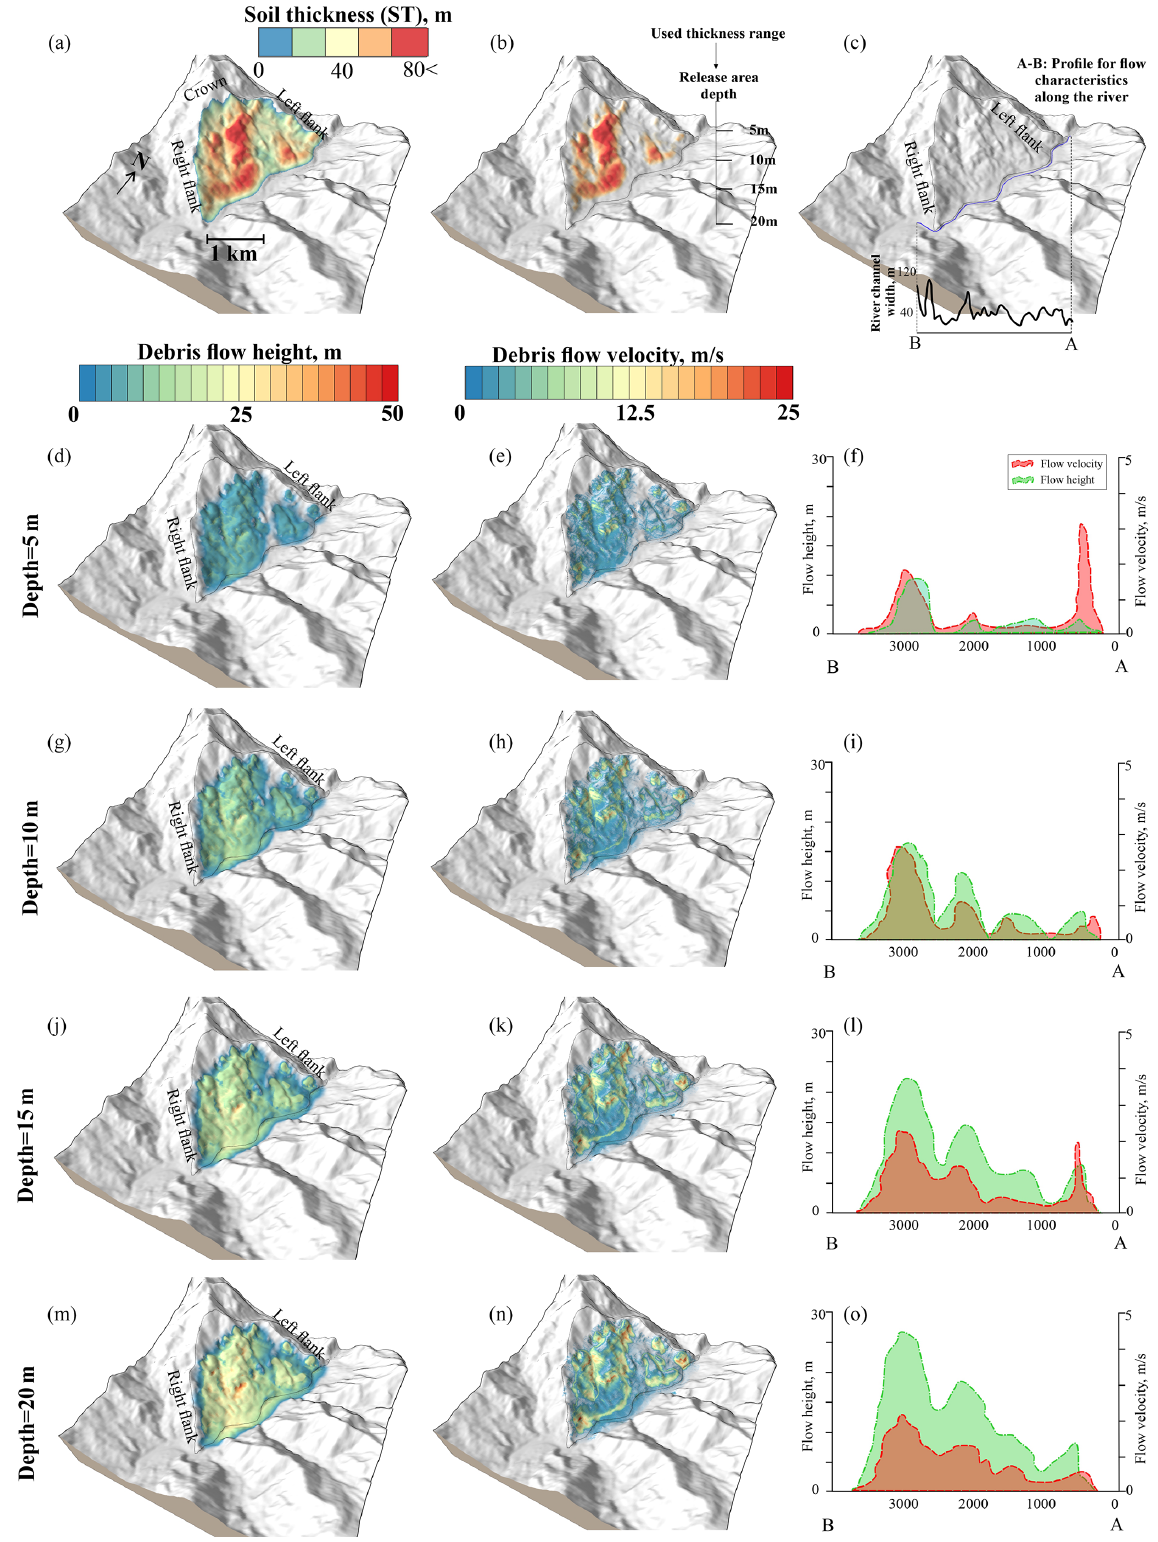
Figure 13. Debris flow runout pattern. (a) Soil (or debris) thickness pattern in the landslide. (b) Different release area depths (5, 10, 15, and 20m) used for the analysis. (c) River profile section A–B used to represent the resultant debris flow along the river. (d–f) Results at 5m depth. (g–i) Results at 10m depth. (j–l) Results at 15m depth. (m–o) Results at 20m